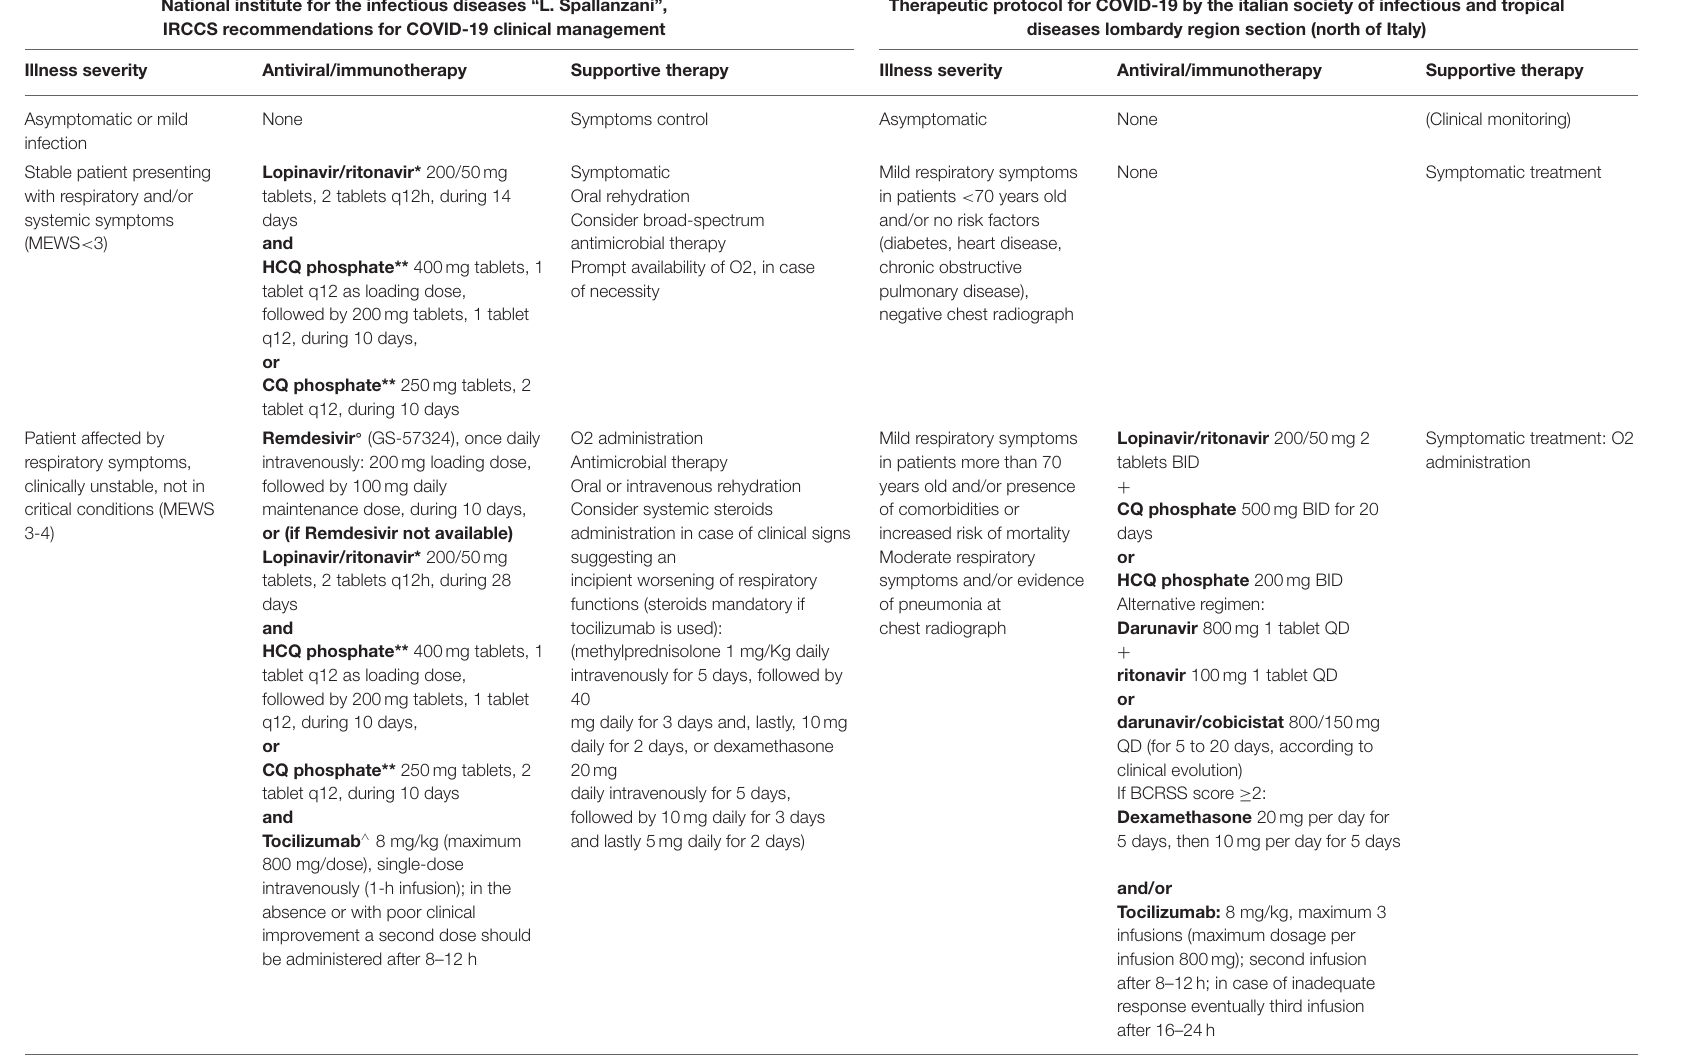
TABLE 1 | Italian Recommendations for Covid-19 treatment: comparison between Spallanzani recommendations and the Italian Society of Infectious and Tropical Diseases Lombardy Region Section (North of Italy) protocol. National institute for the infectious diseases “L. Spallanzani”, Therapeutic protocol for COVID-19 by the italian society of infectious and tropical IRCCS recommendations for COVID-19 clinical management diseases lombardy region section (north of Italy) Illness severity Supportive therapy None Symptoms control Asymptomatic None (Clinical